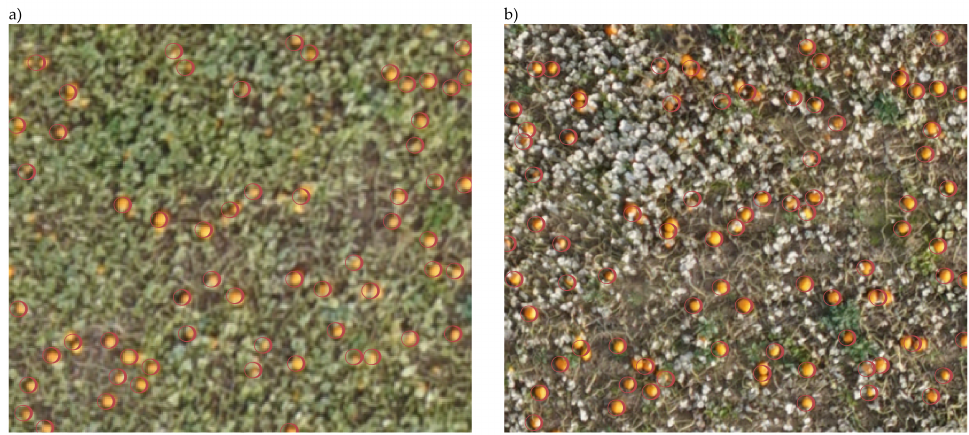
Figure 12. Same section of orthomosaics of field 105-0 for 2020 season 27.08.2020 ( a ) and 17.09.2020 ( b